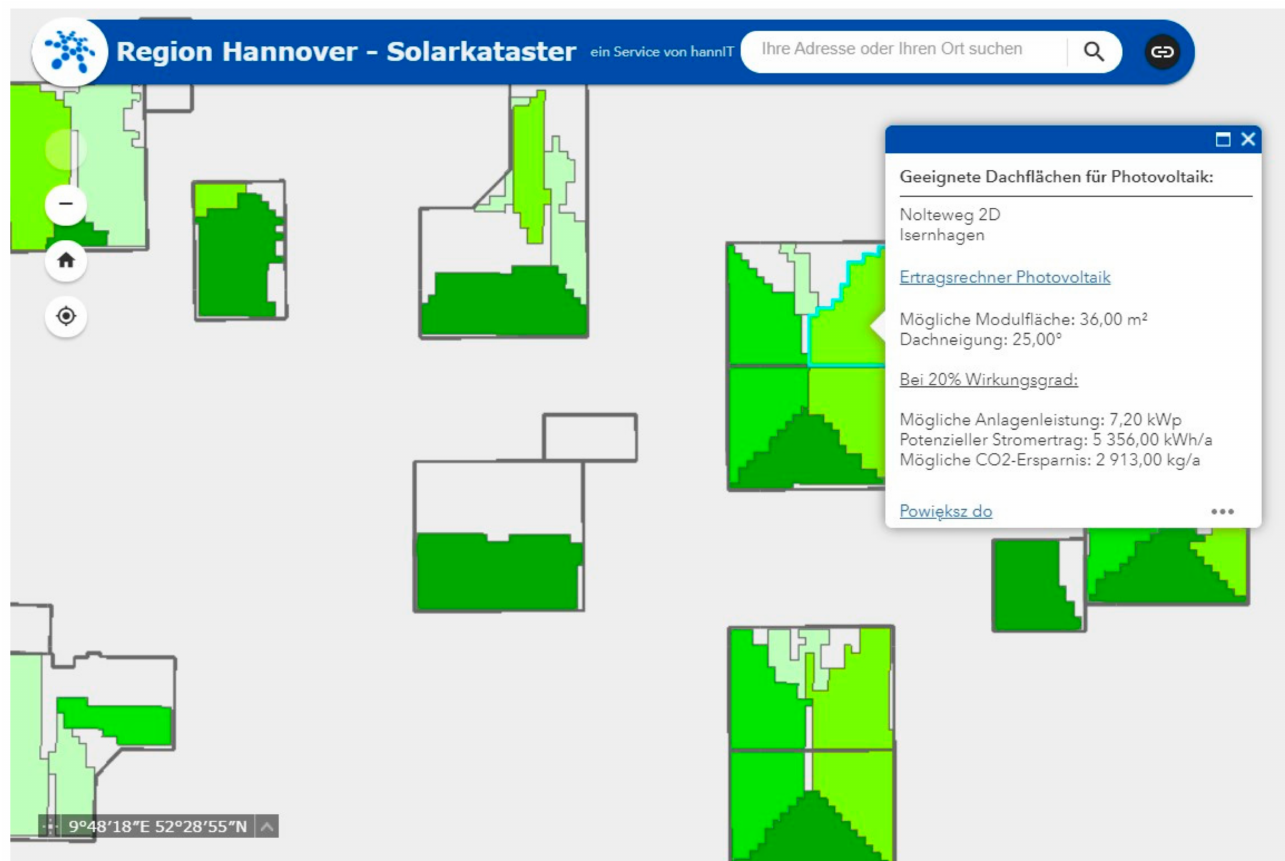
Figure 8. Solar cadastre of the Hanover Region—specification of roof areas suitable for photovoltaics. Source: own study based on